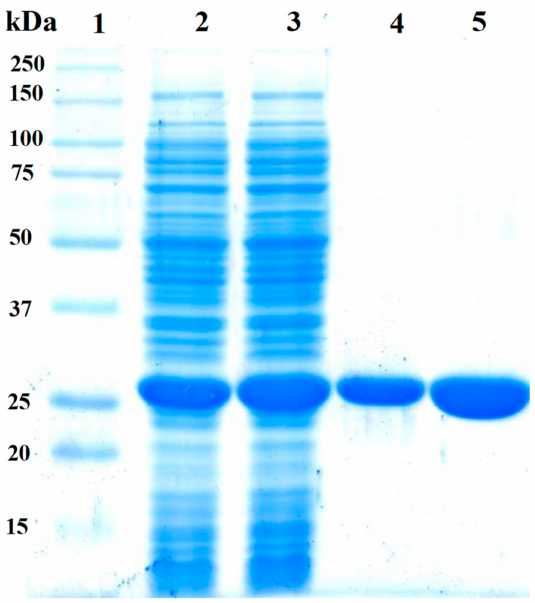
Figure 3. Expression and purification of the recombinant FoxTPI protein analyzed on 12% SDS-PAGE. Lane 1: Marker Precision Plus Protein Kaleidoscope Standards (Bio-Rad, Hercules, CA, USA). Lane 2, Lysate of E. coli BL21(DE3)pLyS cells. Lane 3, crude extract of E. coli BL21(DE3)pLyS cells. Lanes 4 and 5, correspond to 10 µ g and 20 µ g, respectively, of the purified FoxTPI. SDS-PAGE gel was stained